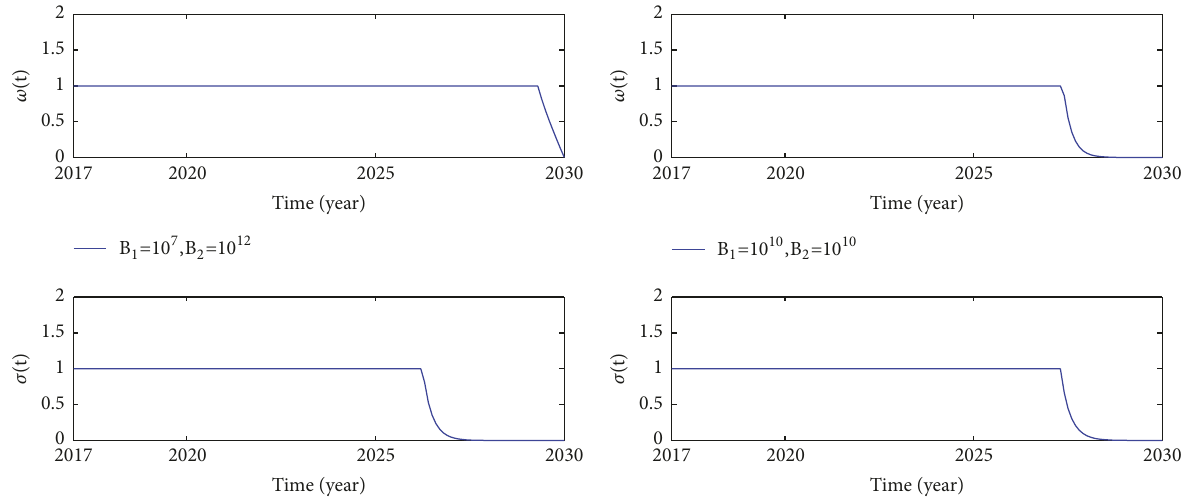
Figure 8: Optimal control plots with different 𝐵 𝑖 when R 0 = 1.0764 . Left: 𝐵 1 = 10 7 , 𝐵 2 = 10 12 . Right: 𝐵 1 = 10 10 , 𝐵 2 = 10 10 .